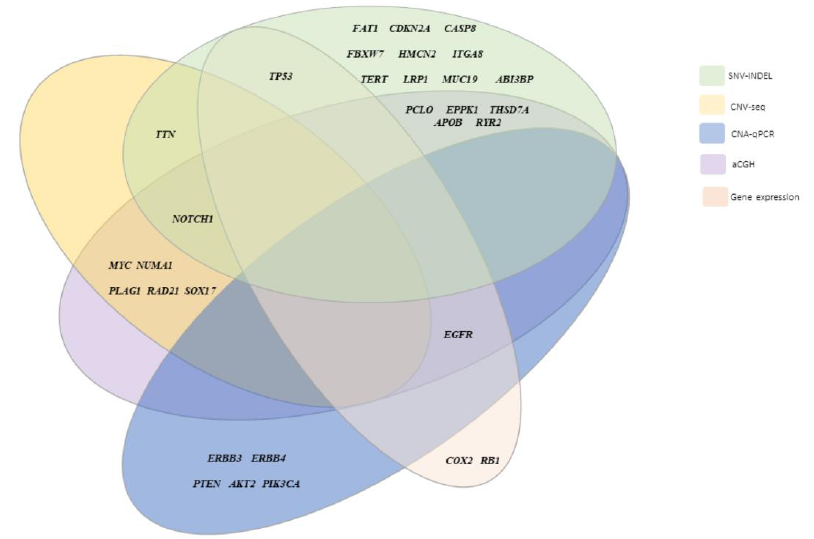
Figure 4. The spectrum of main genes exhibiting somatic variants in human papillomavirus-associated penile squamous cell carcinomas in Latin American patients.